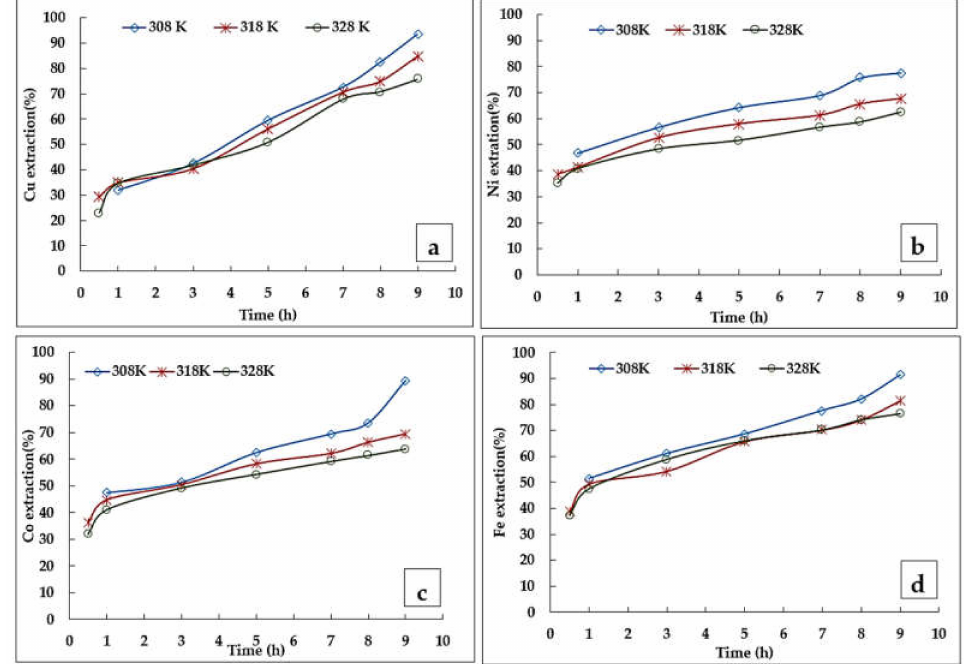
Figure 10. E ff ect of time on recovery of ( a ) Cu, ( b ) Ni, ( c ) Co, and ( d ) Fe at 15% pulp density with 2 N citric acid at various